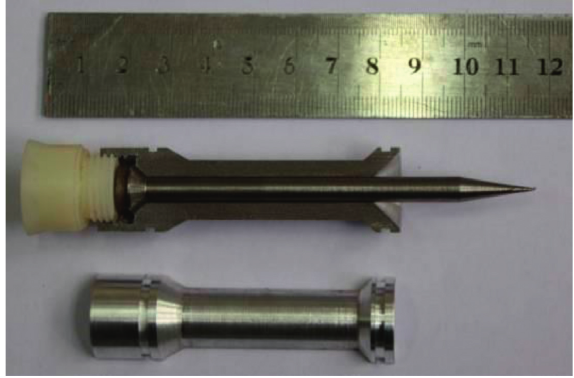
Figure 3: 105mm simulated armor-piercing projectile. Table 1: Materialinformation of projectile and target.